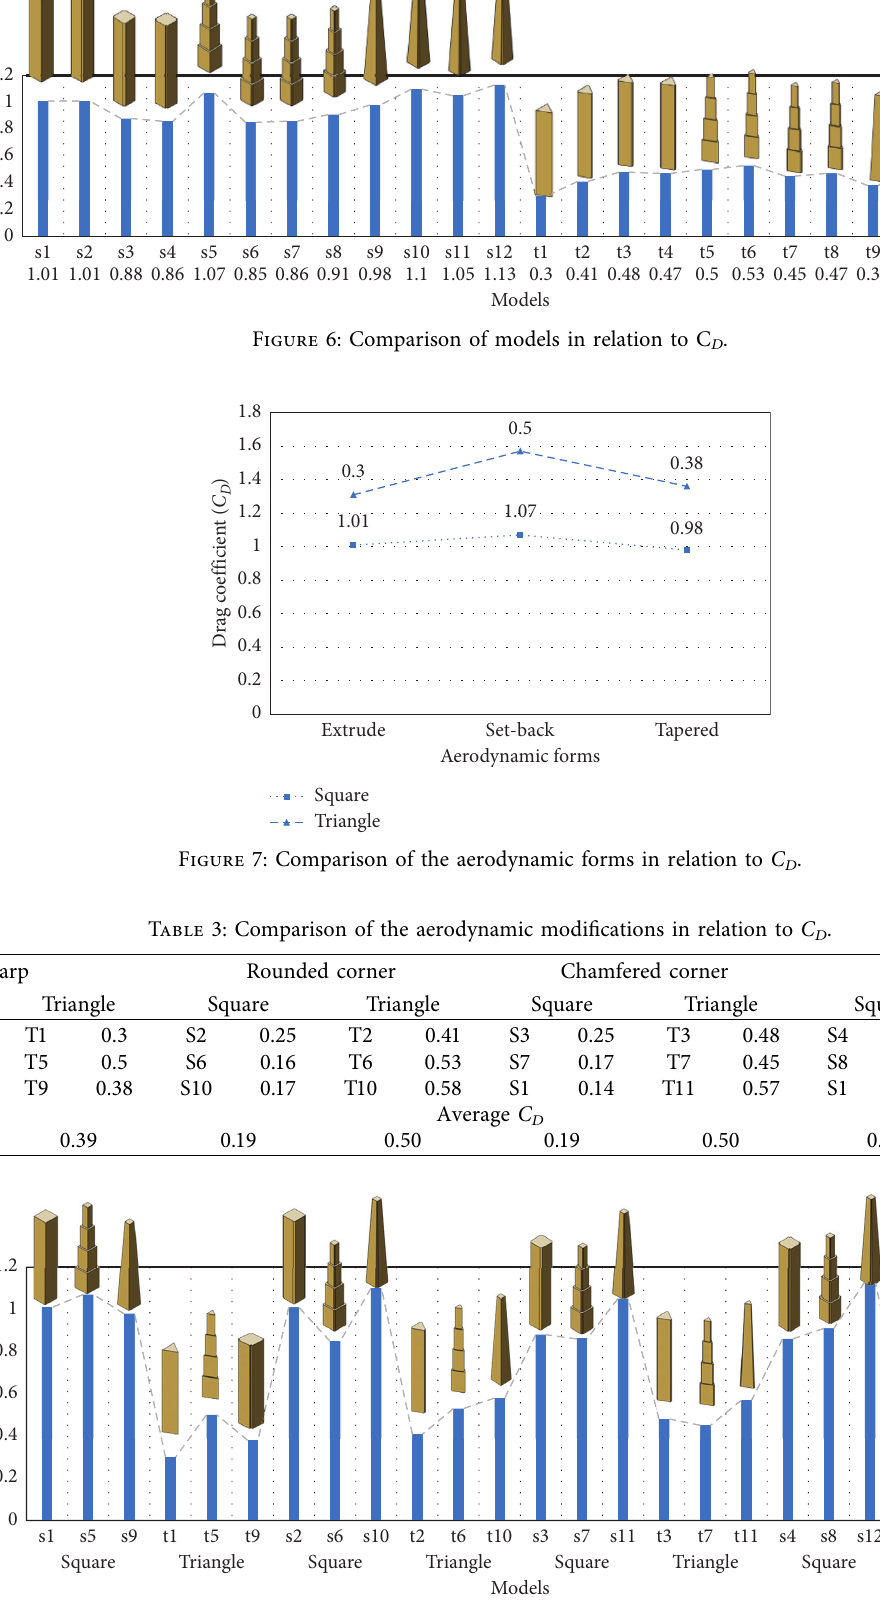
Figure 8: Effects of aerodynamic modifications on reducing C